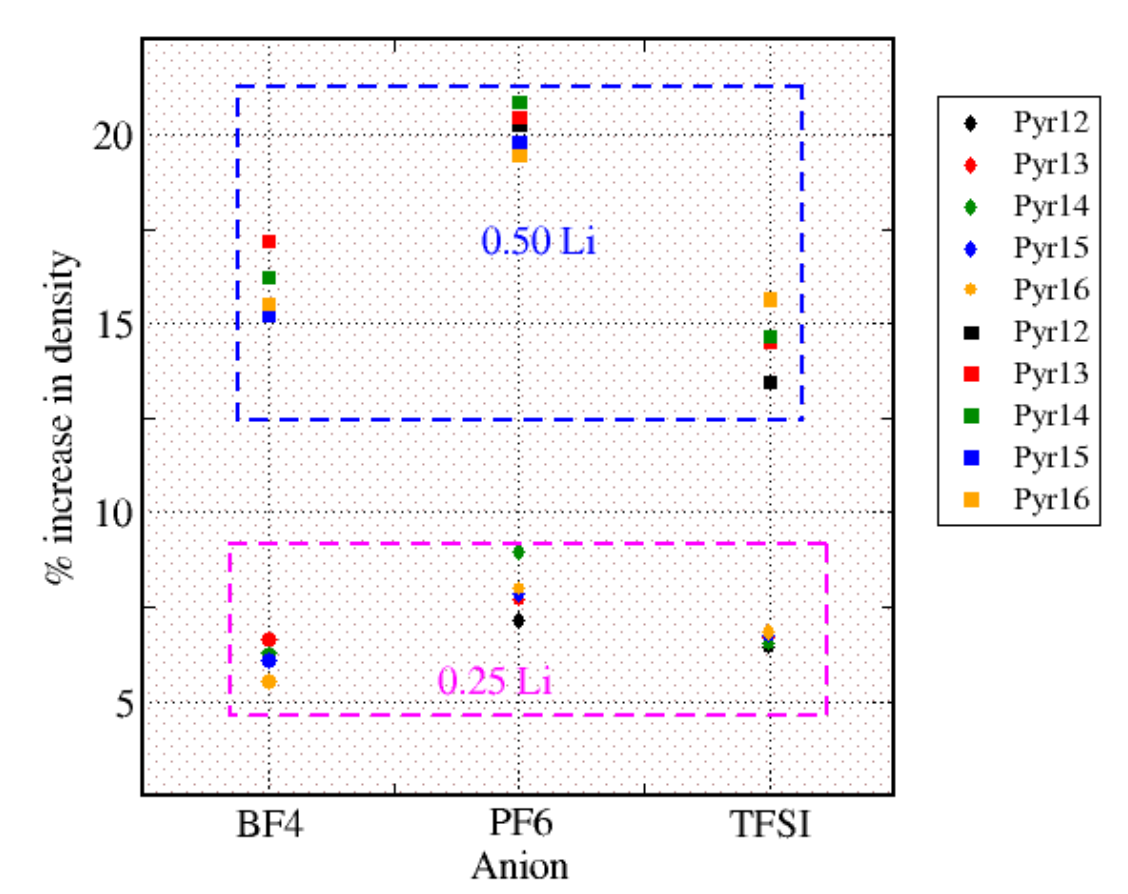
Figure 8. Percentage of the increase in density with respect to the neat ionic